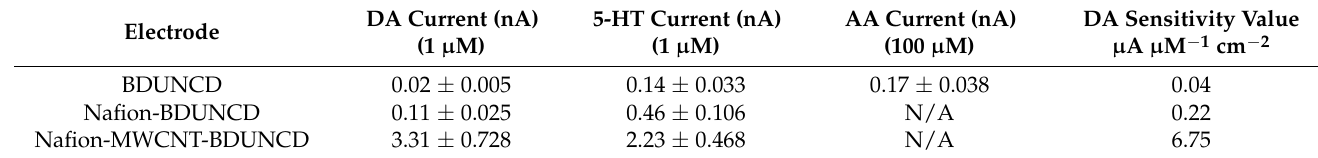
Table 3. Comparison of DPV peak currents from individual (single component) analytes (1 µ M DA, 1 µ M 5-HT, and 100 µ M ascorbic acid